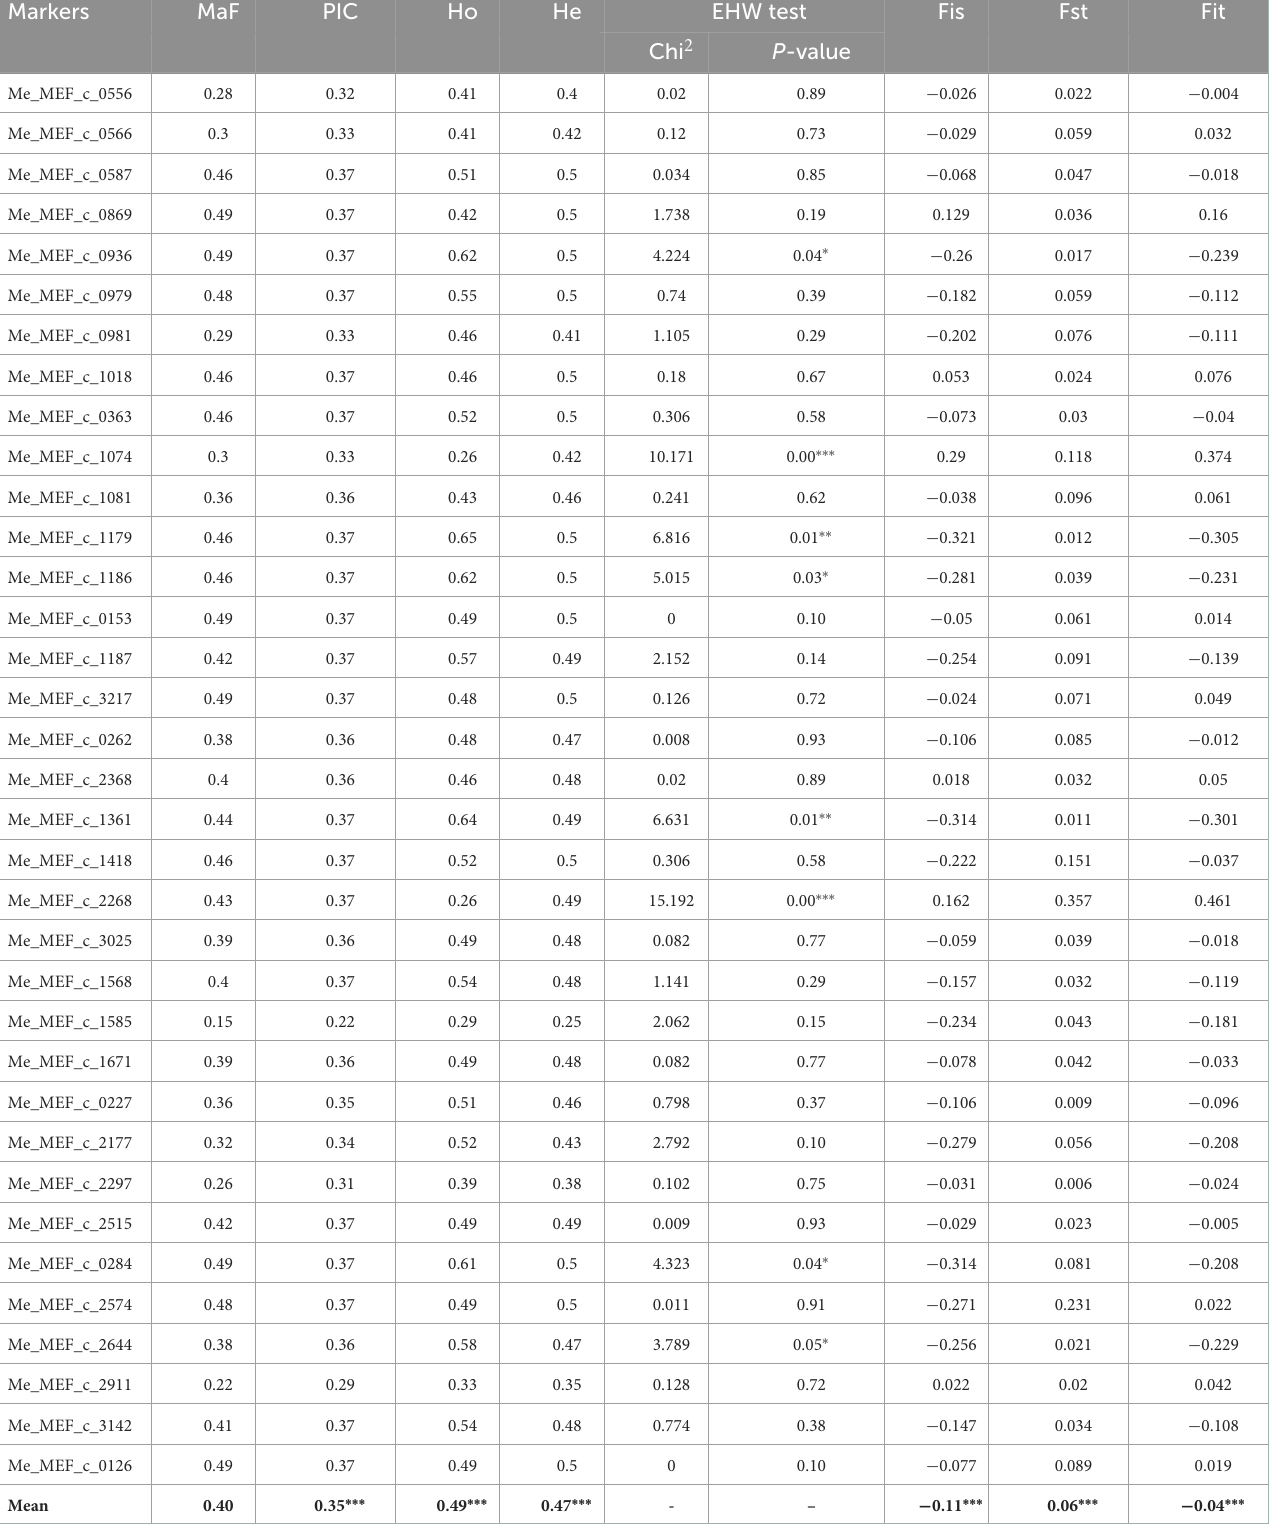
TABLE 5 Common genetic parameters and F-statistics for each locus of the 36 single nucleotide polymorphism (SNP) markers used for the genotyping selected Côte d’Ivoire cassava germplasm.